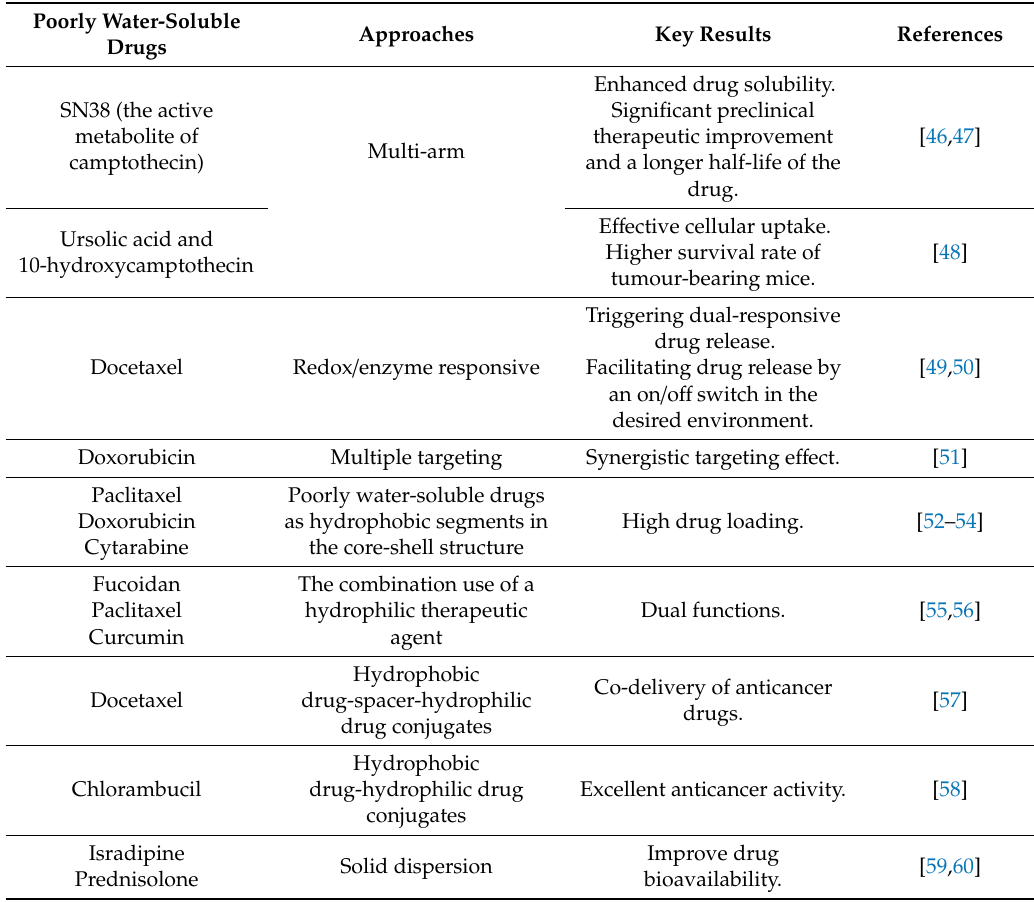
Table 1. Examples of studies on nanoconjuagtes of poorly water-soluble drugs for